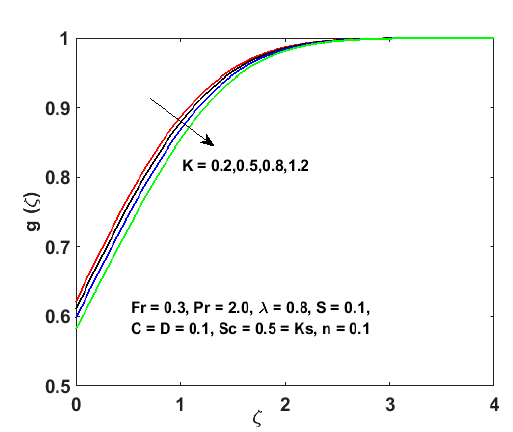
Figure 9. Effect of K on Figure 9. E ff ect of K on g ( ζ ) .